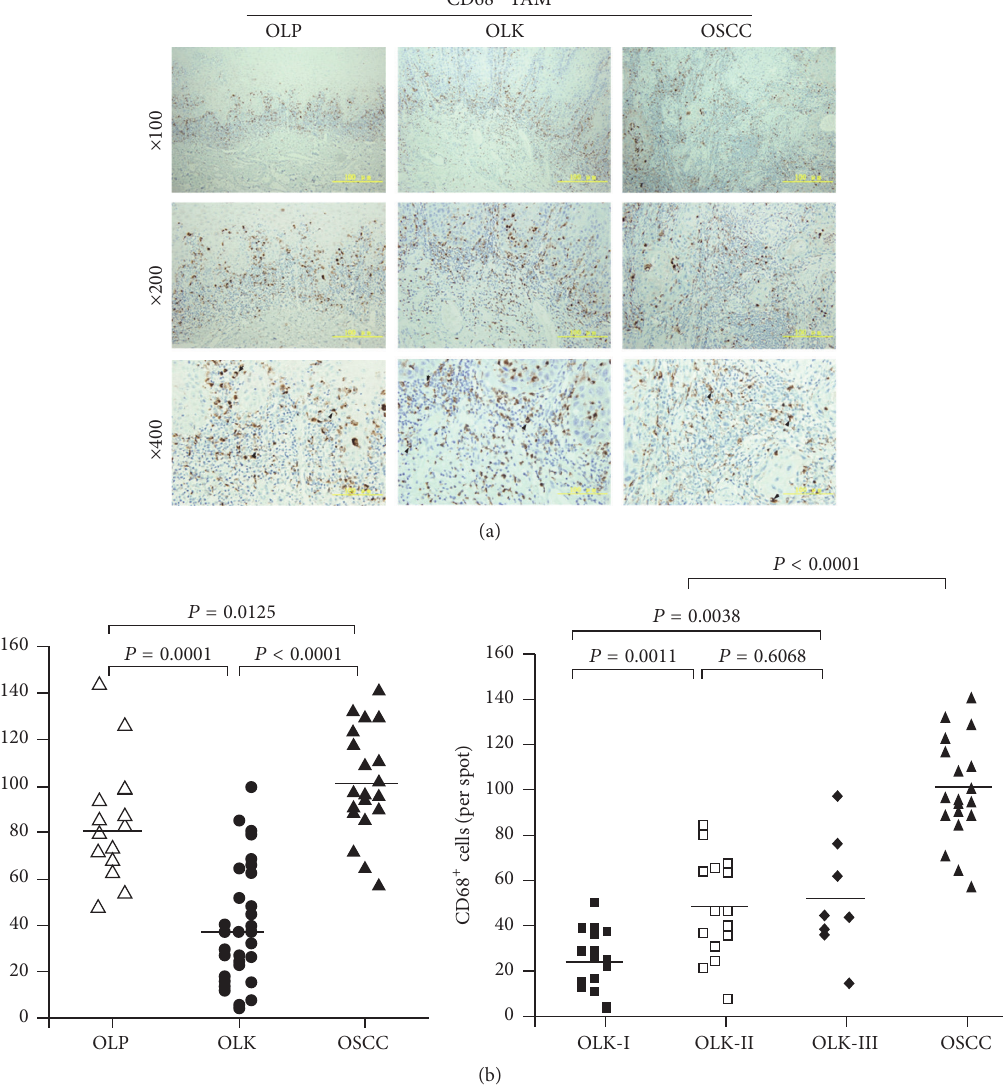
Figure 2: Distribution and proportion of CD68 + TAM cells in OLP, OLK, and OSCC tissues. (a) CD68-immunostained sections. (b) Frequency of CD68 + TAM